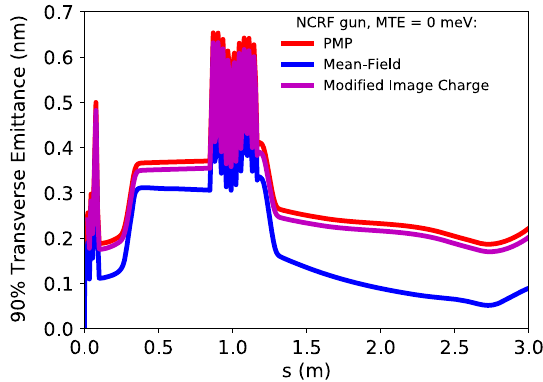
FIG. 17. Transverse normalized rms emittance comparison for point-to-point, mean-field, and modified image charge simula- tions for the NCRF UED beam line with 0 meV